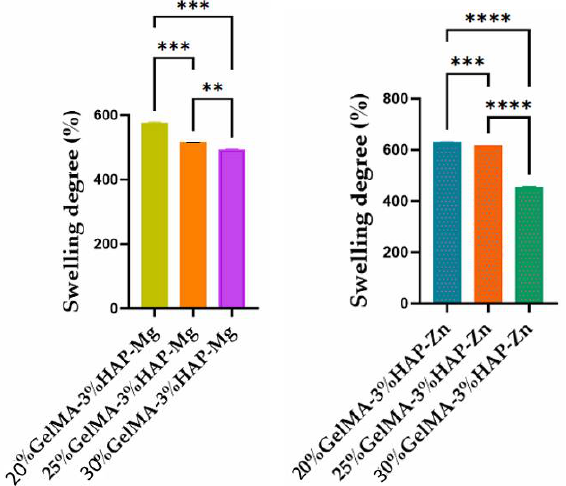
Figure 10. Swelling degree of GelMA-inorganic filler. Statistical significance: **** p < 0.0001, *** p < 0.001, and ** p < 0.01.